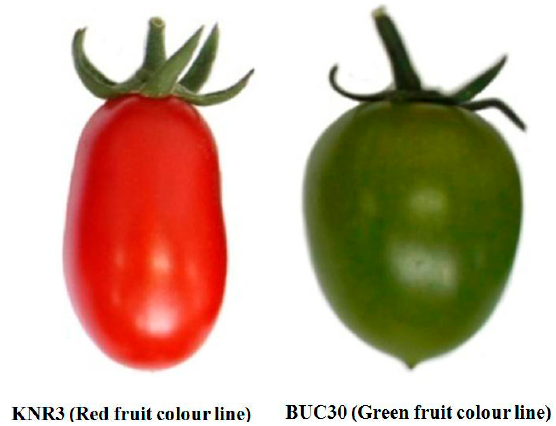
Figure 1. Comparison of fruit pigmentation in the red-fruited line (KNR3) and the green-fruited line (BUC30) at the completely-ripened stage achieved 57 days after pollination.